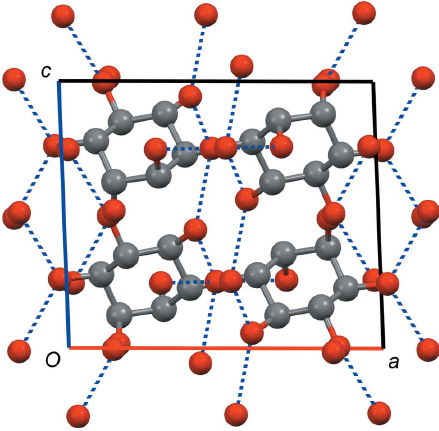
Figure 5 Crystal structure of racemic chiro -inositol ( rac - 1 ). Space group P 2 1 / c , view along the b axis ( a axis shown in red, c axis shown in blue). Hydrogen bonds are indicated as dashed blue lines, H atoms have been omitted for clarity.